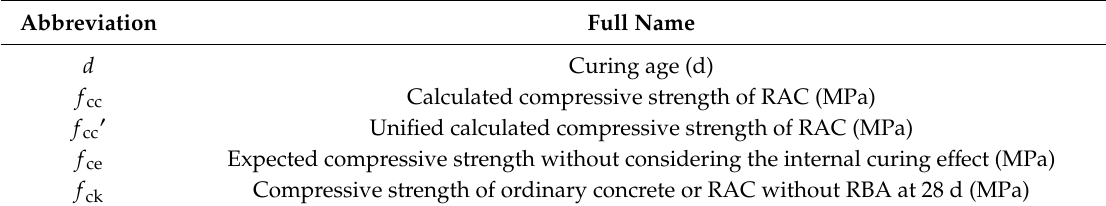
Figure 15. Unified comparison between the tested and calculated compressive strengths.